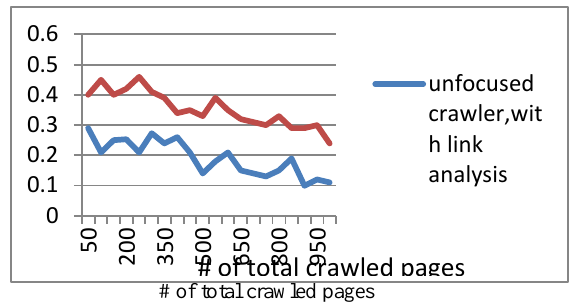
Figure 8. Comparison of unfocused crawler, with link analysis and ontology-based crawler, with link analysis